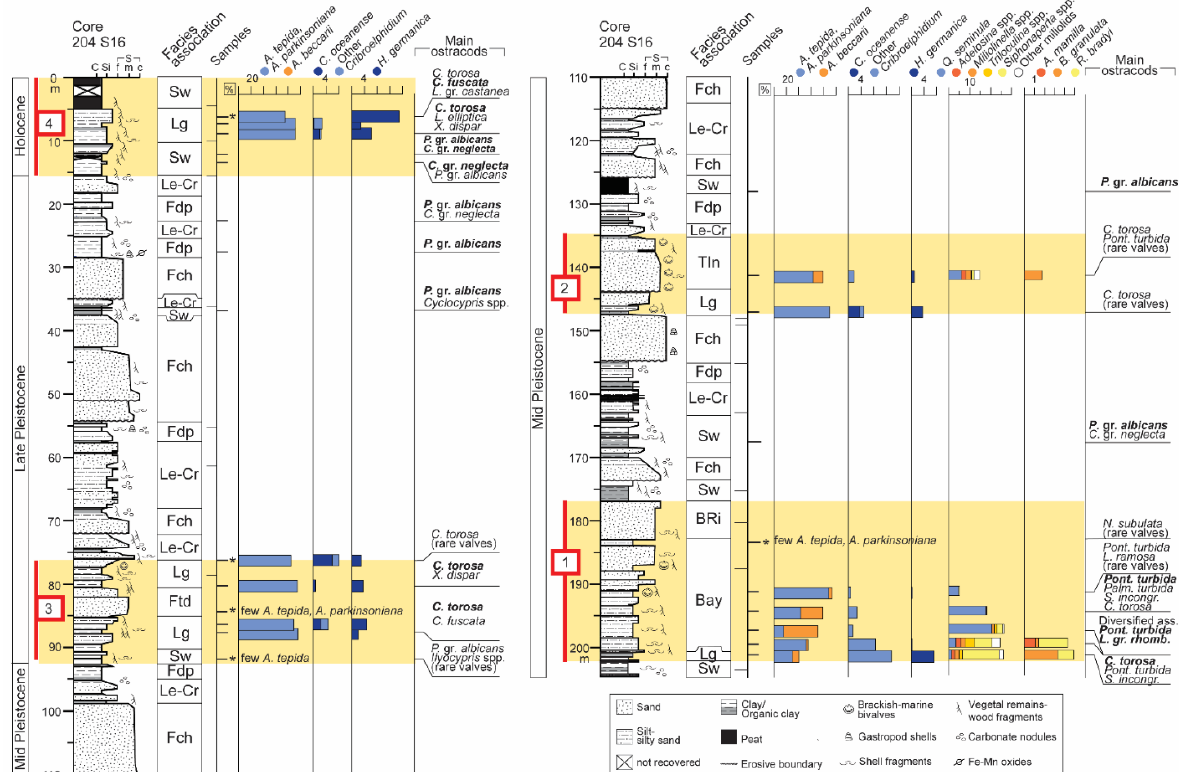
Figure 3. Stratigraphy and facies characterization of the studied core 204 S16. Paralic to marine units rich in meiofauna are highlighted and numbered in stratigraphic order (Units 1–4). Abbreviations of facies associations are explained in text (Section 4). Sedimentological features are reported along with the meiofauna content; samples barren of autochthonous meiofauna are shown on the left. Asterisks mark samples containing less than 100 tests of benthic foraminifers. Relative abundances of main benthic foraminifer taxa are displayed, as well as the vertical distribution of key taxa composing ostracod assemblages (dominant taxa are highlighted in bold). Miliolids and epiphytic species, as A. mamilla , B. granulata and R. bradyi , are not represented in the 0–110 m interval due to their extreme paucity (<1.5%). C: Clay; Si: Silt; S: sand (f: fine, m: medium, c: